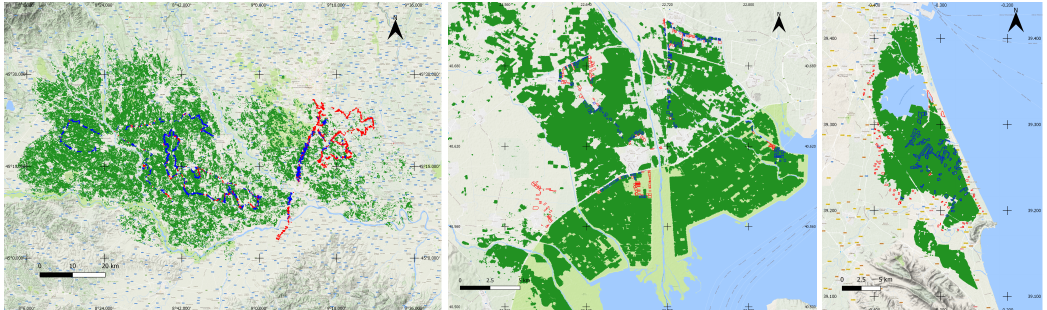
Figure 2. Rice area for Italy (IT) (left), Greece (GR) (middle) and Spain (ES) (right) at the end of the 2016 season and points/field boundaries over rice (red) and not rice (blue)